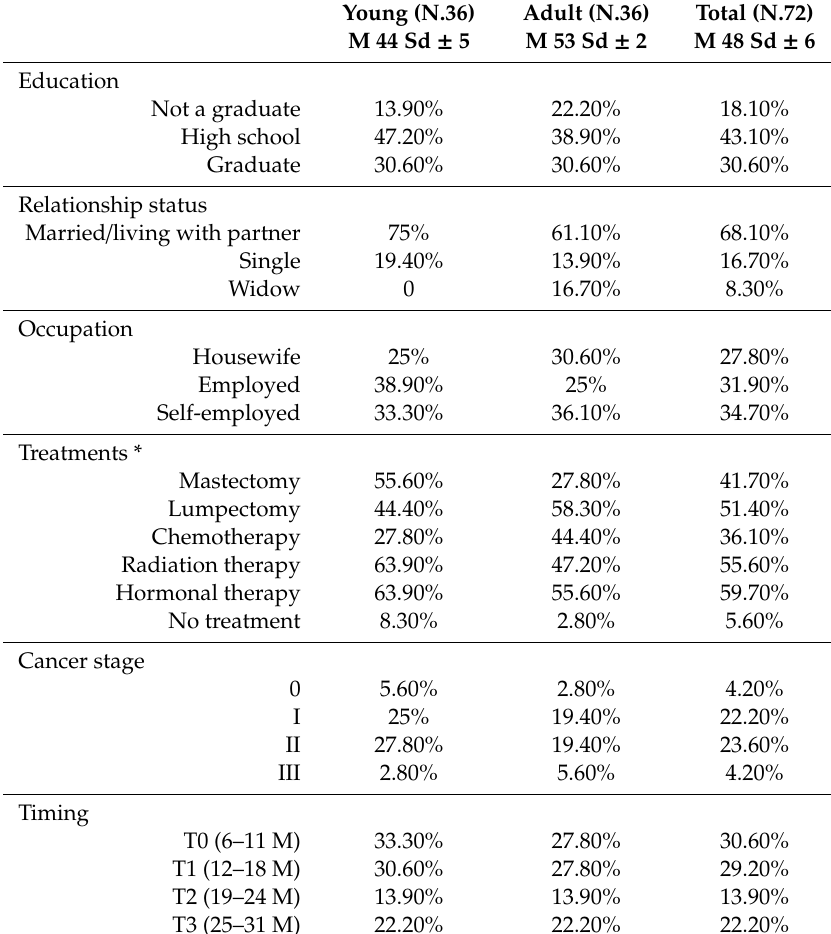
Table 1. Demographic data of participants in the